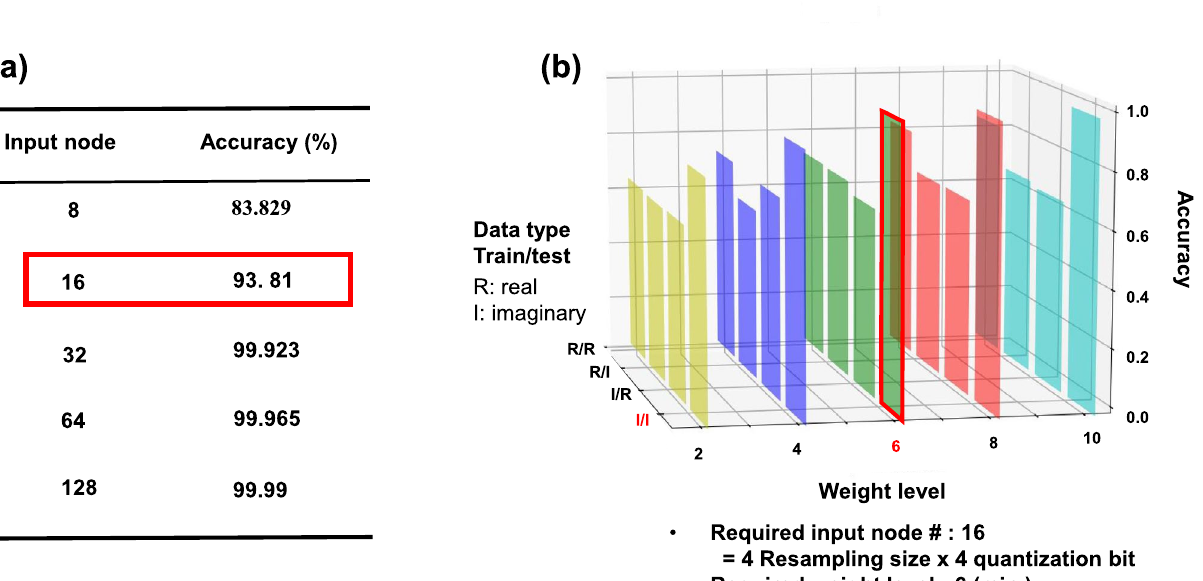
Figure 4. Optimized conditions of the S-DNN. For implementation of the H-DNN, the S-DNN was optimized to minimize hardware sources. ( a ) Input node dependence of recognition accuracy. For more than 90 % of accuracy, at least 16 input nodes are required. ( b ) Optimization of various parameters such as data type, weight level, and input data preparation method (resampling size and quantization bit). More details about optimization of the S-DNN is described in the supplementary figures (Figs. S2–S4). For high recognition accuracy with minimized hardware source, 16 input nodes (4 resampling size and 4 quantization bit), imaginary input data, and 6 weight levels were utilized.